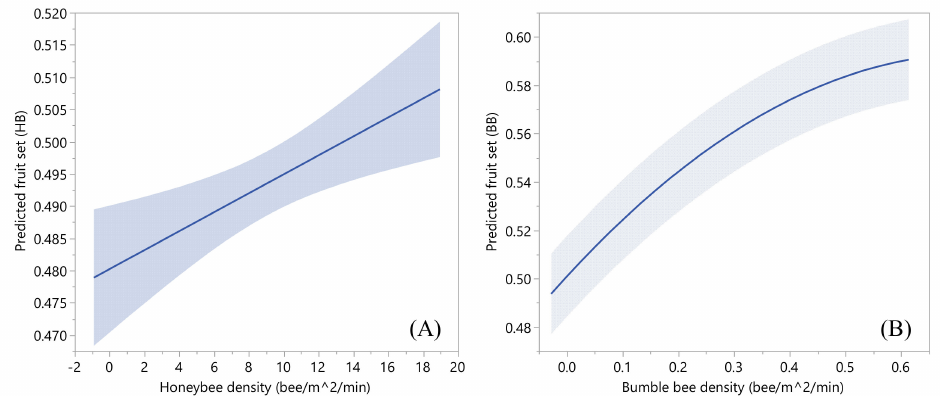
Figure 11. Predicted bog blueberry proportion fruit-set based on the density of commercial honeybee density ( A ) and bumble bee density ( B ) using the XGBoost model parameterized for recent weather conditions while keeping other parameters at default values. Blue-grey areas around the trend lines represent a 95% confidence interval